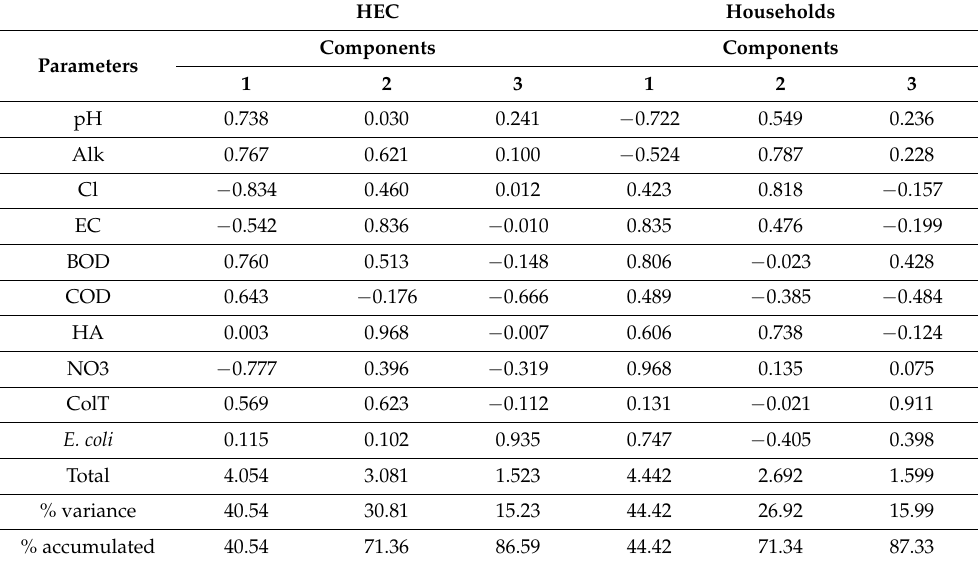
Table 5. Matrix of the principal components for higher education center (HEC) and households.